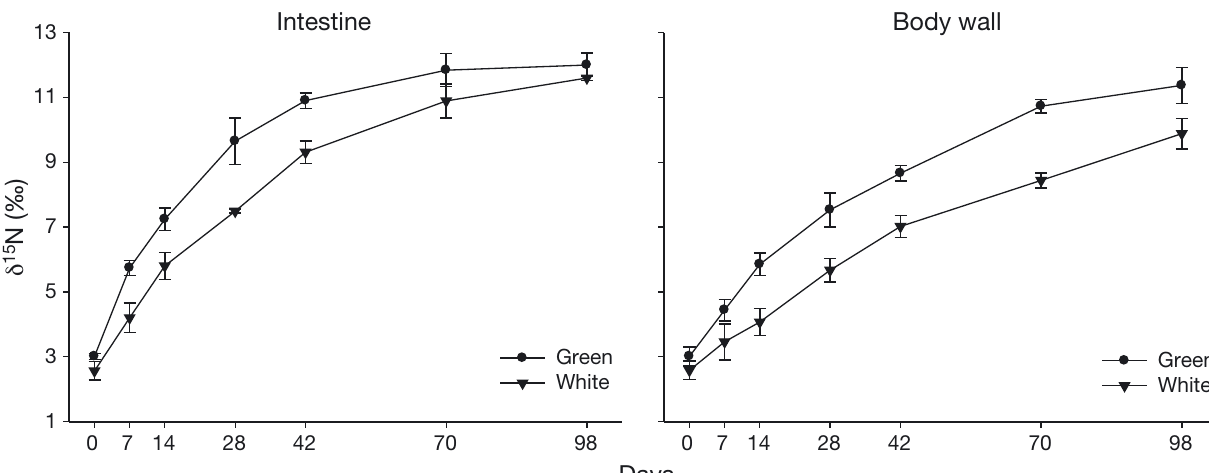
Fig. 1. Temporal changes in the observed δ 15 N values for intestine and body wall of green and white sea cucumber fed single natural diet of Sargassum